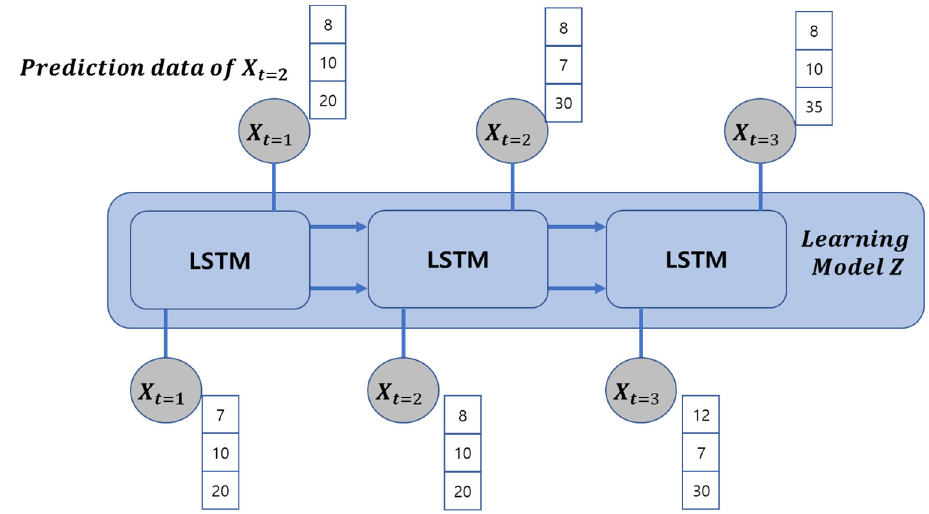
Figure 2. Self-Supervised LSTM model for Fault Prediction.